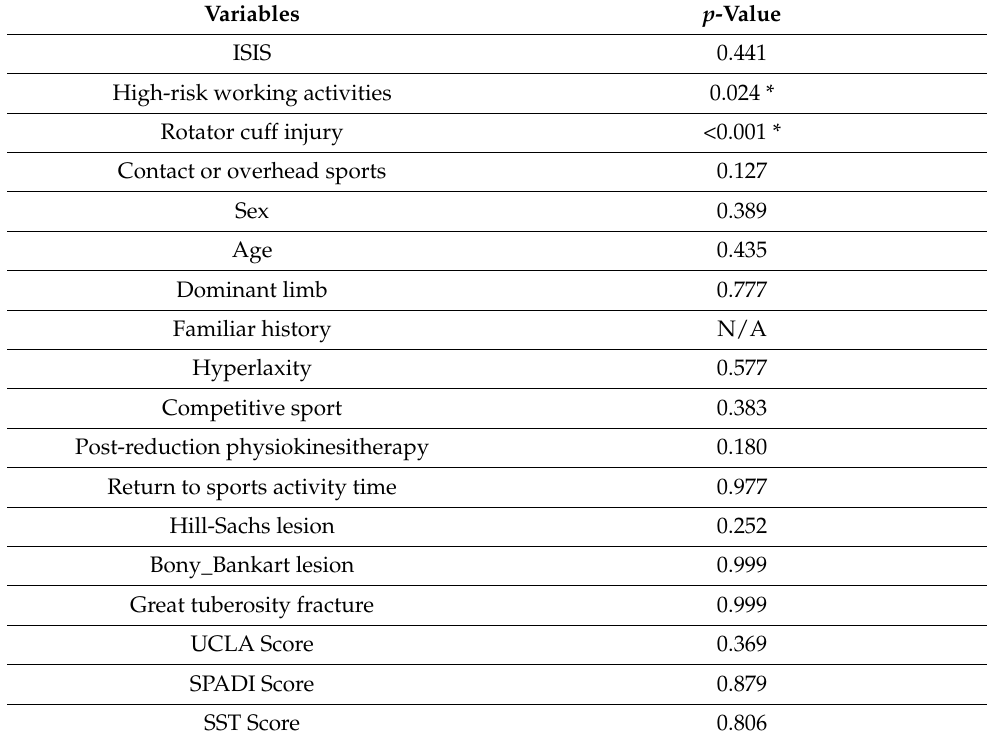
Table 3. Variables associated with the presence of RSD, analysed using binary regression logistic model. Variables p -Value ISIS